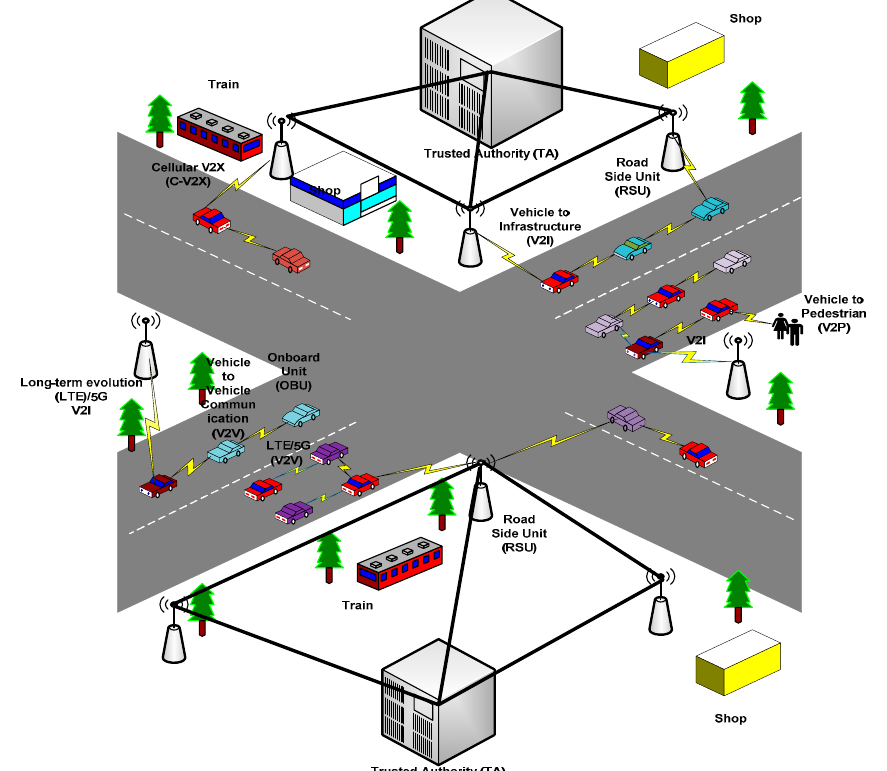
Figure 1. VANET model diagram.